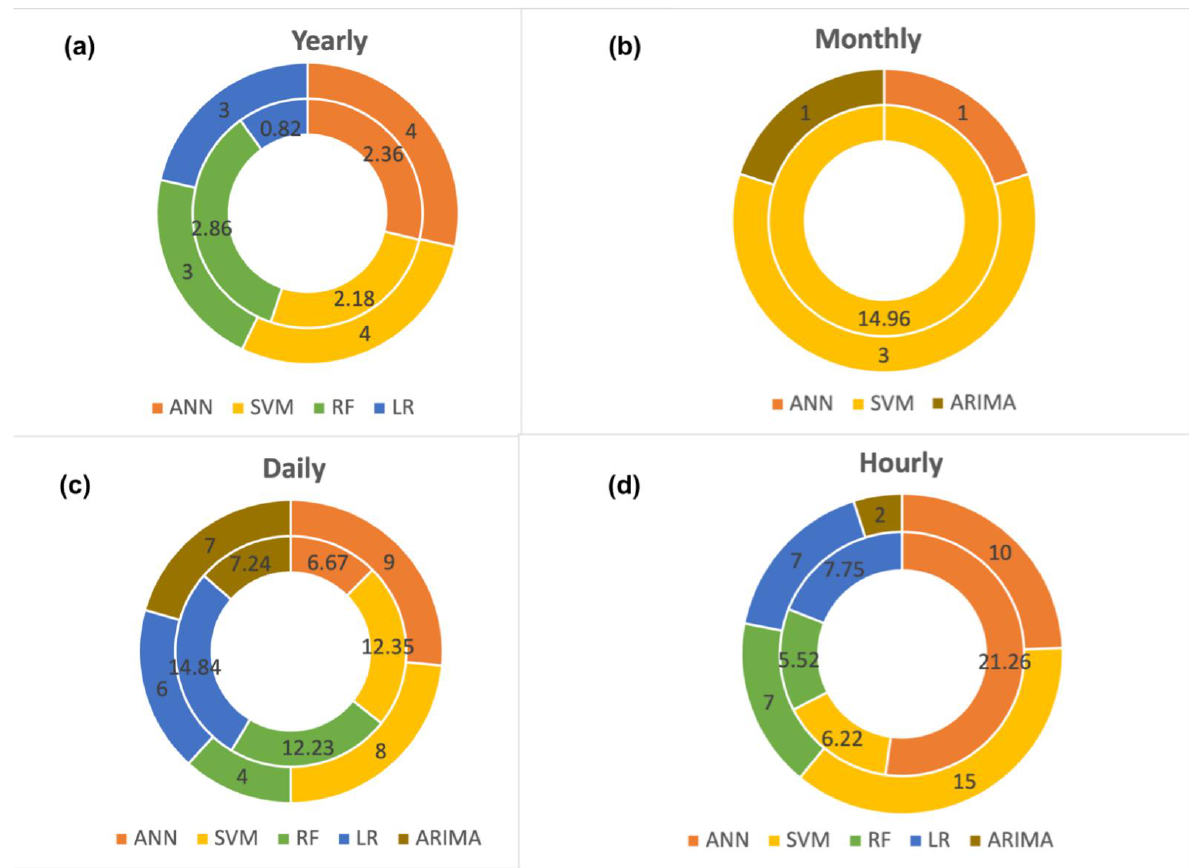
Figure 5. Number of studies and average performance values of each for specific granularity of energy prediction — ( a ) yearly, ( b ) monthly, ( c ) daily, ( d ) hourly.